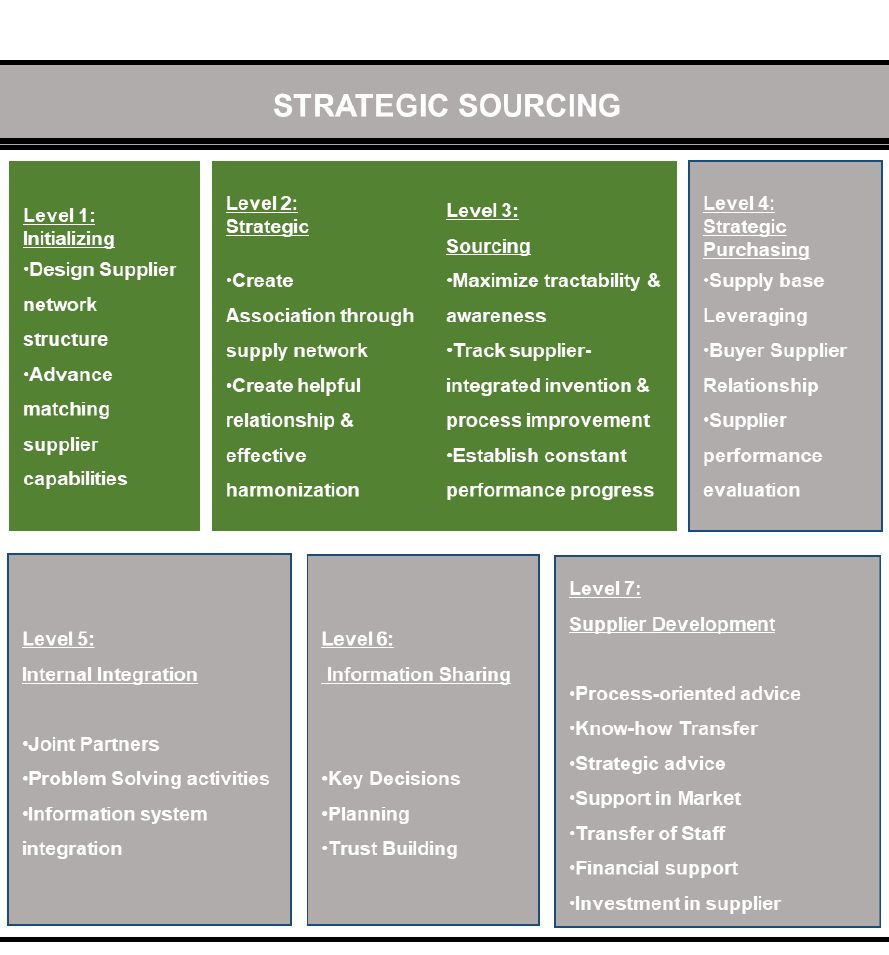
Figure 3: Proposed performance measurement system in strategic sourcing process offootwear supply chain in